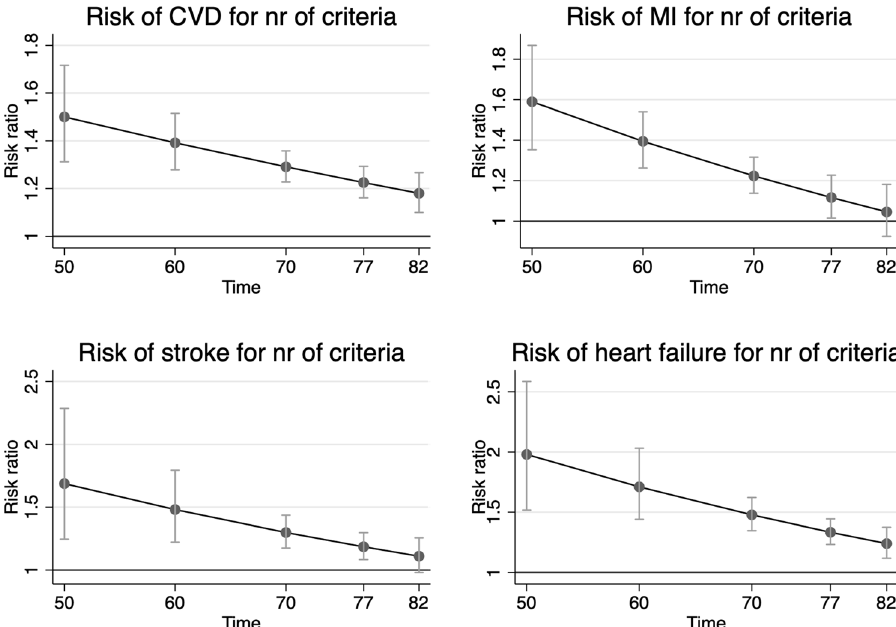
Figure 2. Risk ratio and 95% confidence interval for the number of metabolic syndrome components regarding incident cardiovascular disease (CVD, combined end-point of the other three outcomes), myocardial infarction, ischemic stroke and heart failure. The RRs were adjusted for LDL cholesterol, education level (years in school), leisure time exercise habits, smoking and use of medication against dyslipidaemia. The graphs were created using STATA16 33